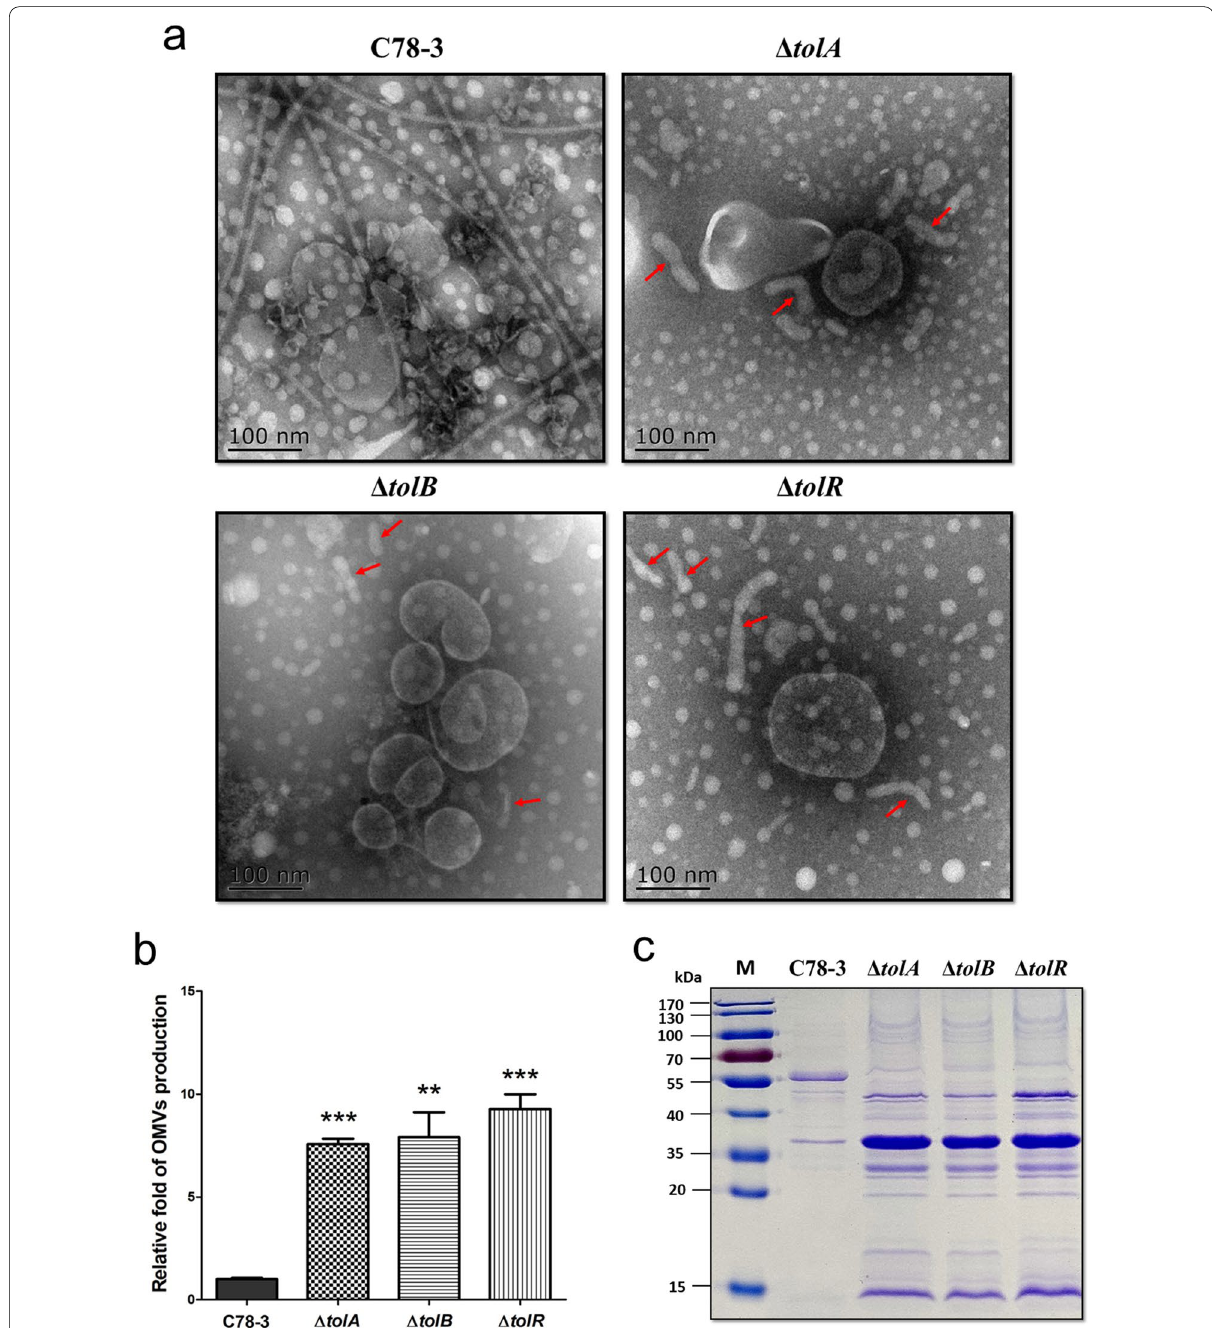
Fig. 5 The involvement of tolA , tolB , and tolR in OMVs biogenesis of S. Choleraesuis. a OMVs derived from C78-3, Δ tolA , Δ tolB , and Δ tolR were evaluated by TEM. b OMVs production of C78-3 and its three mutants. The yield of OMVs was determined by quantitating the protein concentration. The assay was completed in 3 independently conducted biology duplicates. * P < 0.05; ** P < 0.01; *** P < 0.001. c SDS-PAGE profile of OMVs derived from C78-3, Δ tolA , Δ tolB , and Δ tolR strains. Proteins were visualized using Coomassie Brilliant Blue